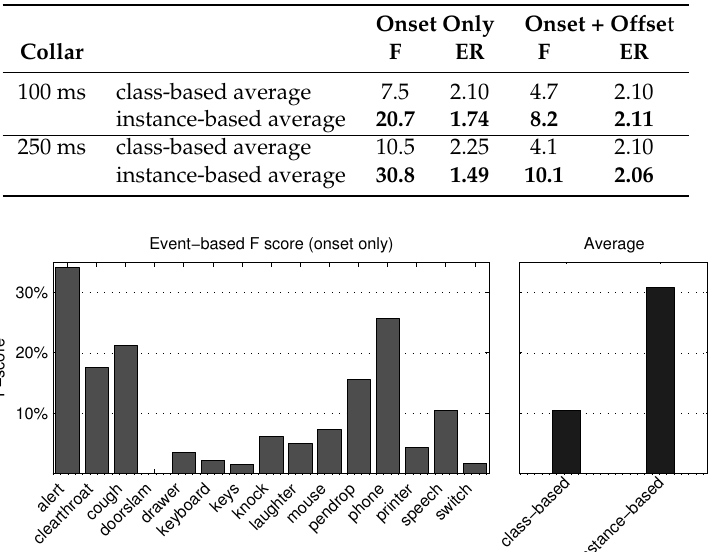
Table 2. Event-based F-score and ER calculated on the case study system.